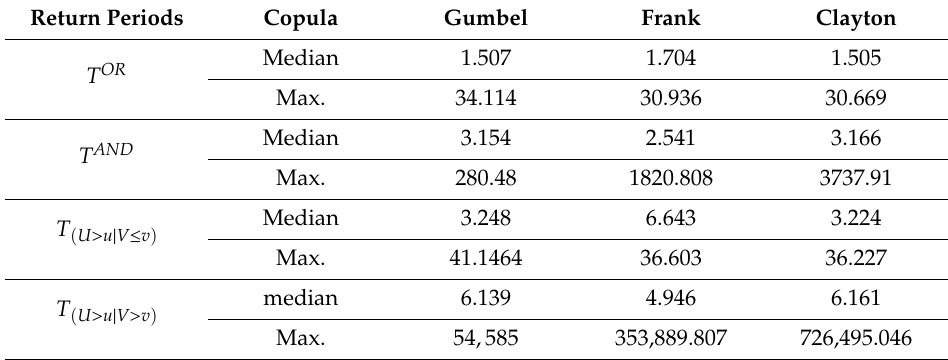
Table 7. Primary and conditional return periods for copulas at the median and maximum values of P and V .